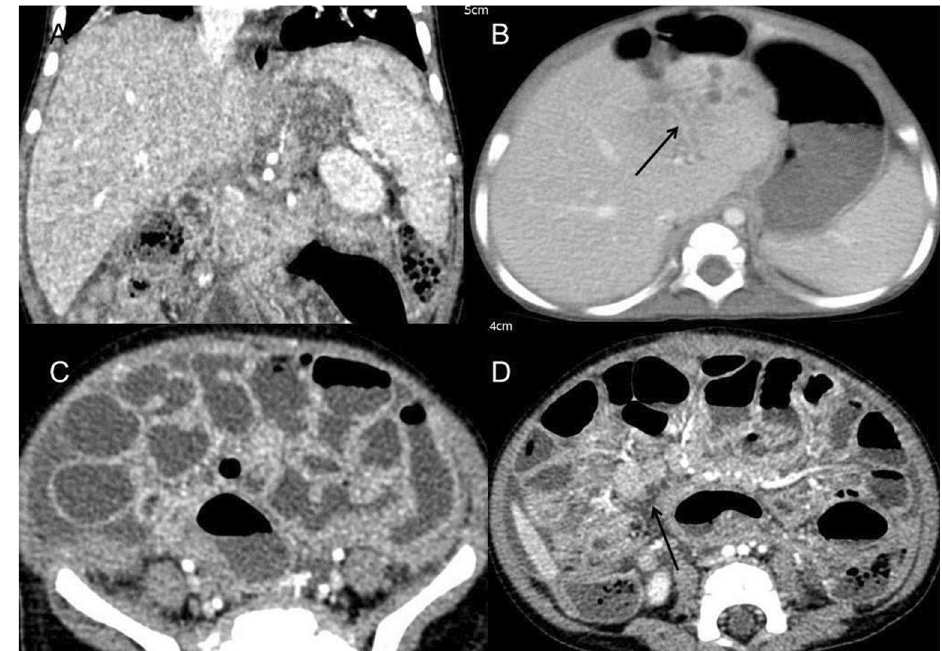
Figure 3. Abdominal visceral involvements of BCG infection. ( A ) Coronal post-contrast CT showed hepatosplenomegaly with homogeneous enhancement in a 1-year-old boy. ( B ) A 8-month-old boy with hepatic abscess. CT scan demonstrated the presence of multiple low-attenuated lesions in the left lobe (long arrow). Most lesions were less than 5 mm and some with ring enhancement. Edema around the left portal vein were also noticed. ( C , D ) A 1-year-old boy with enteritis. The widely thickened intestinal wall and effusion within the lumen were found on abdominal CT. The small amount of ascites also accompanied. The enlargement of mesenteric lymph nodes was noticed ( D , long